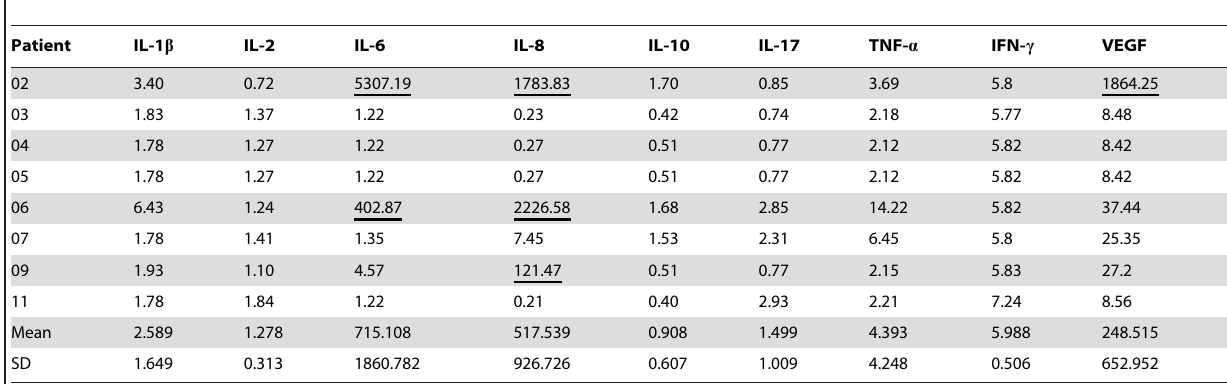
Table 4. 9 cytokines concentrations measured by Multiplex Assay in intra-FCVB fluid